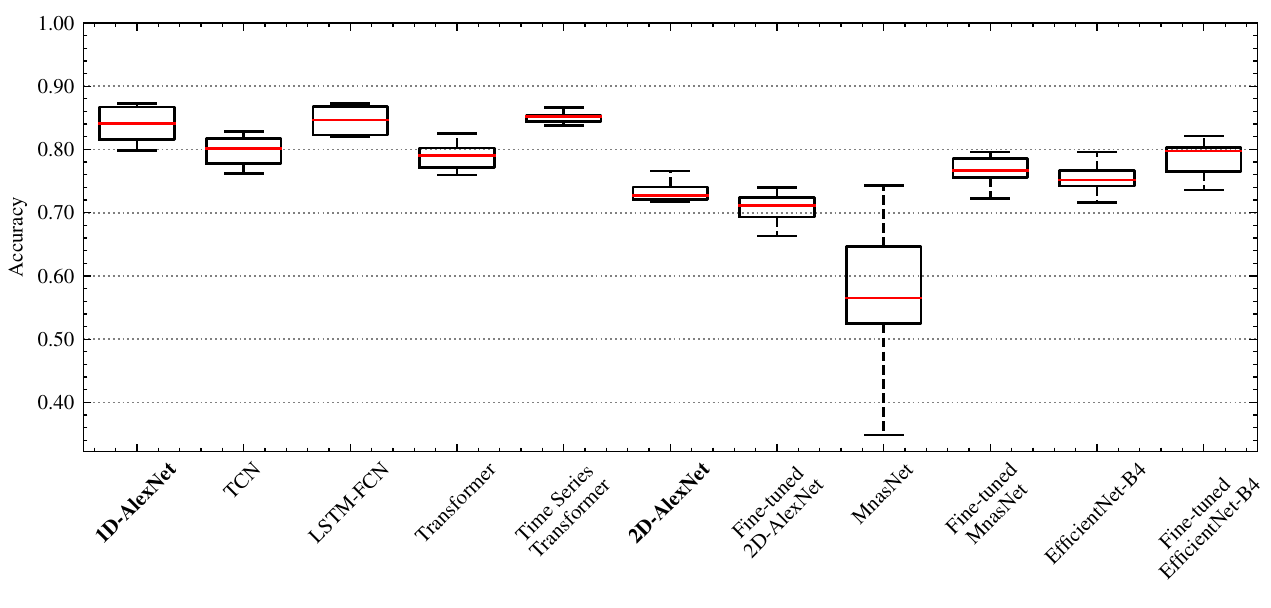
Figure 12. Box and whisker plot for the distributions of accuracy scores (considering the augmented dataset). Boxes extending from the first quartile below to the third quartile above. The median line is in red, and whiskers extend to the minimum and maximum